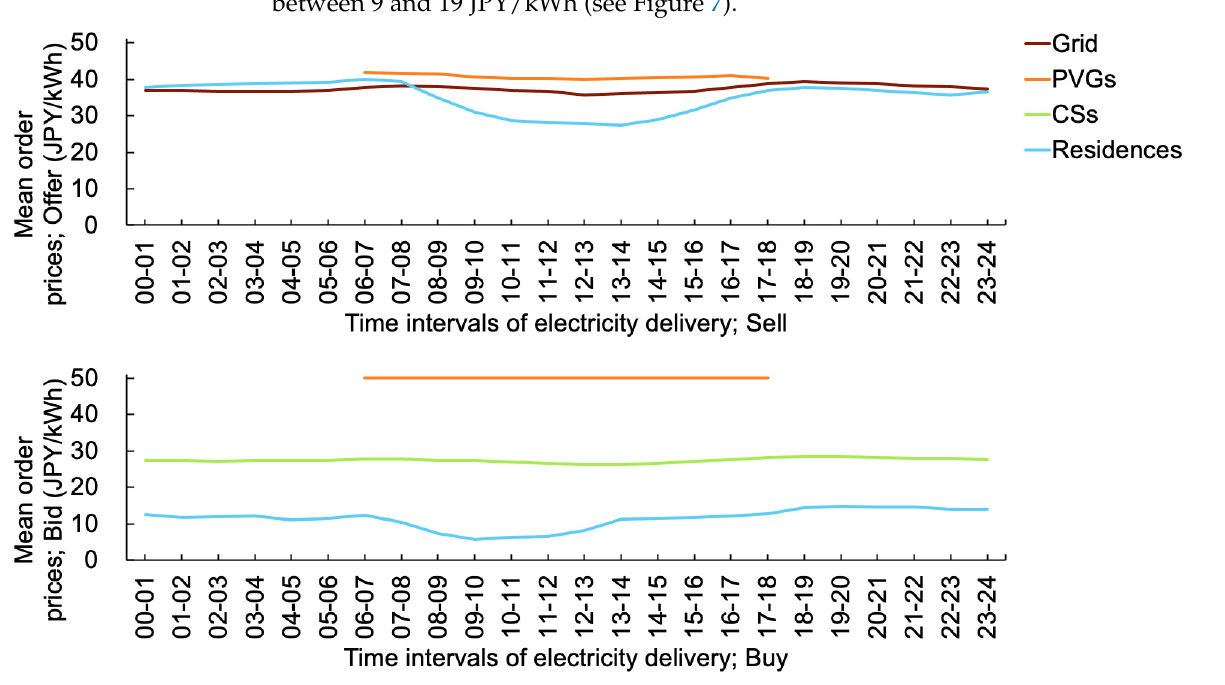
Figure 11. Mean order prices for each time interval in the target period.